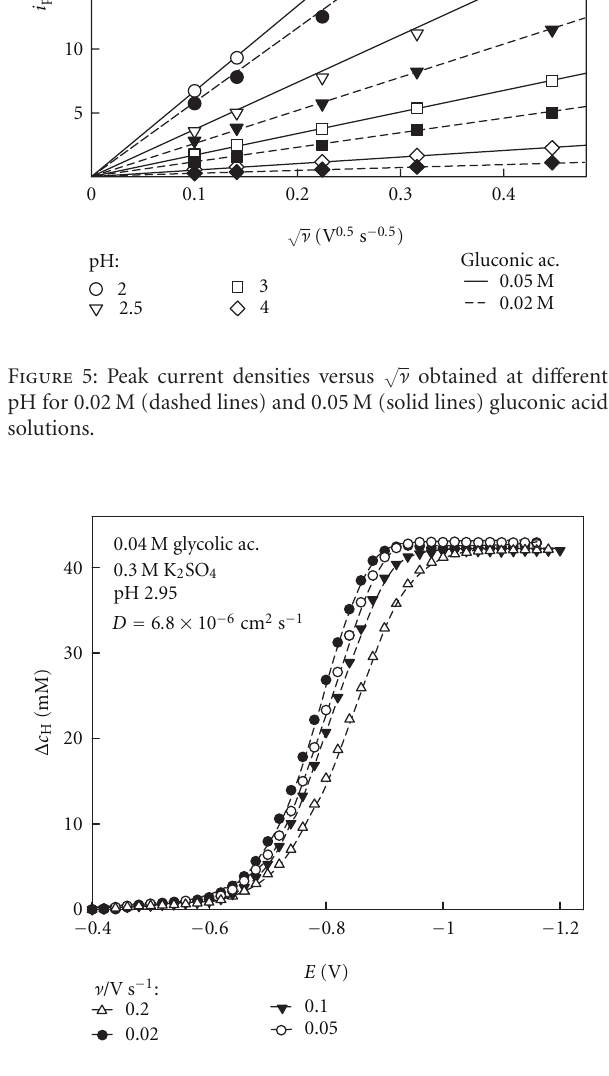
Figure 6: Changes in the surface concentration of proton donors calculated by (10) from voltammetric data obtained for 0.04 M glycolic acid solution at di ff erent potential sweep